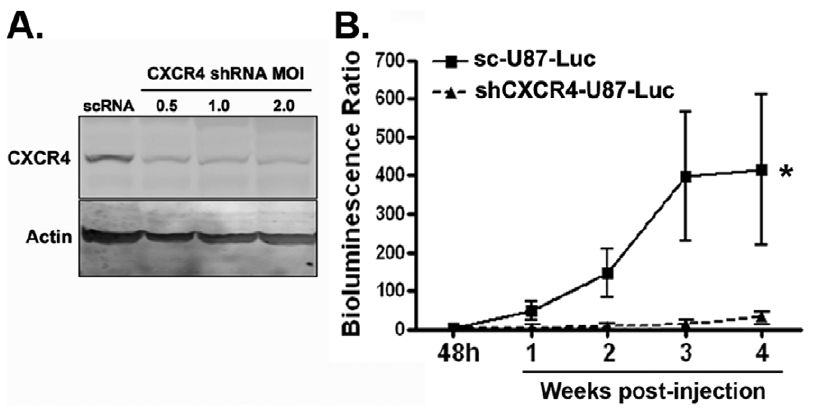
Figure 1. Deletion of CXCR4 suppresses the growth of intracranial U87 xenografts. ( A ) Western blot analysis of CXCR4 expression in U87 cells infected with lentirvirus encoding a scrambled shRNA control (scRNA) or a short hairpin RNA directed against CXCR4 (CXCR4 shRNA). CXCR4 expression declined with increasing viral mulitplicity of infection (MOI). ( B ) Animals were injected with U87 cells expressing either control (scrambled, sc-U87-Luc) or a CXCR4 specific shRNA (shCXCR4-U87-Luc). Growth curves were derived from serial bioluminesence imaging measurements (six to eight animals per experimental group) over the four-week experimental period post tumor cell implantation. Presented are the mean Bioluminescence Ratios (photon flux week (1–4)/photon flux hr48) 6 SEM for each group. * = P , 0.005 as determined by two-way ANOVA.